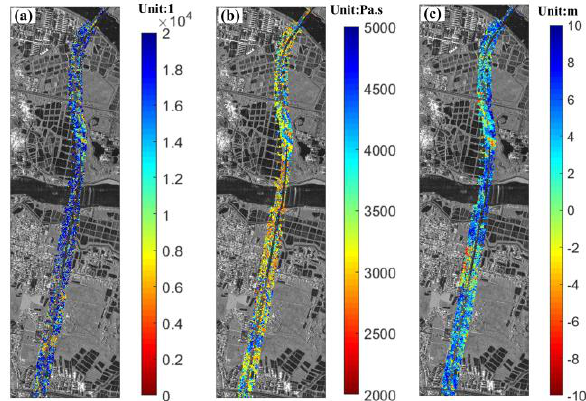
Figure 4. Estimated parameters: (a) viscosity;(b) elasticity modulus and (c) height